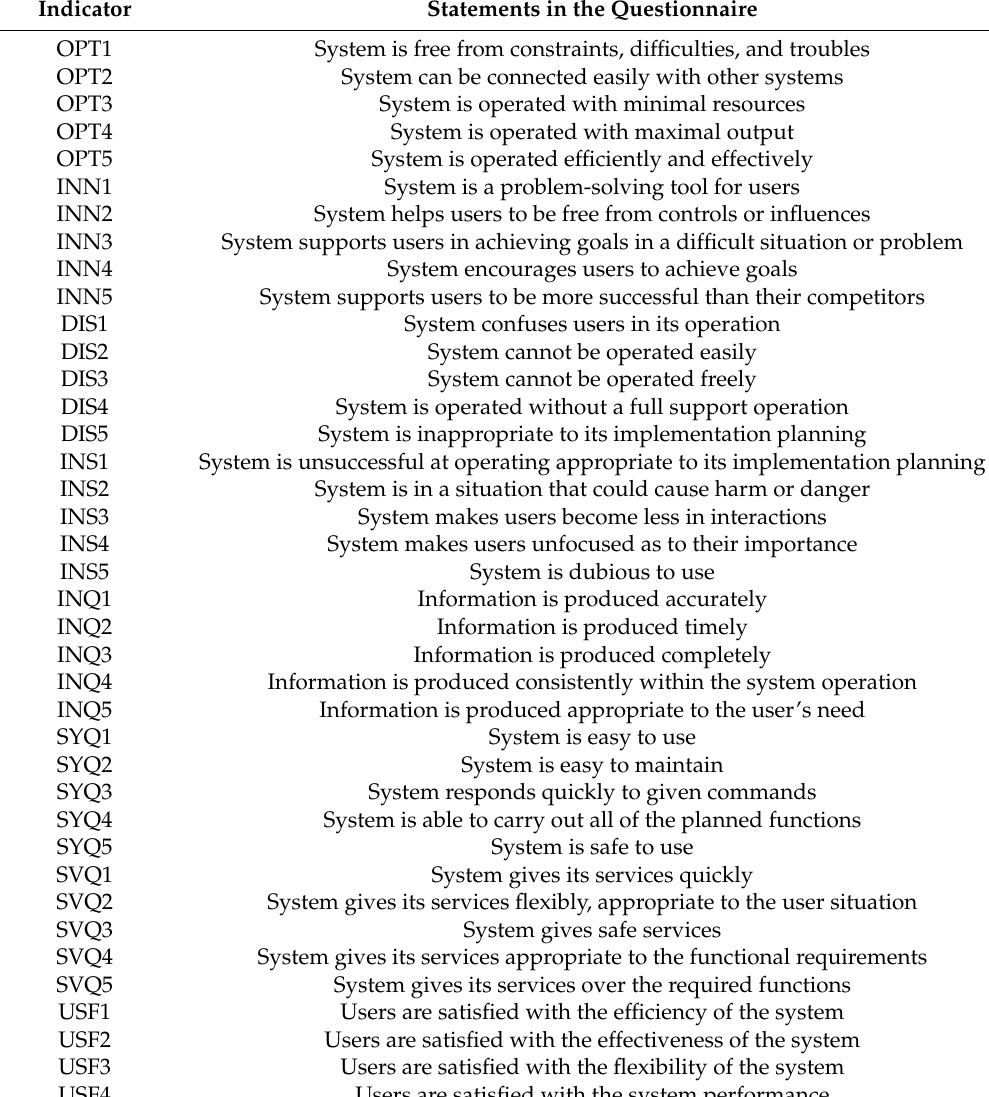
Table 2. List of questionnaire statements